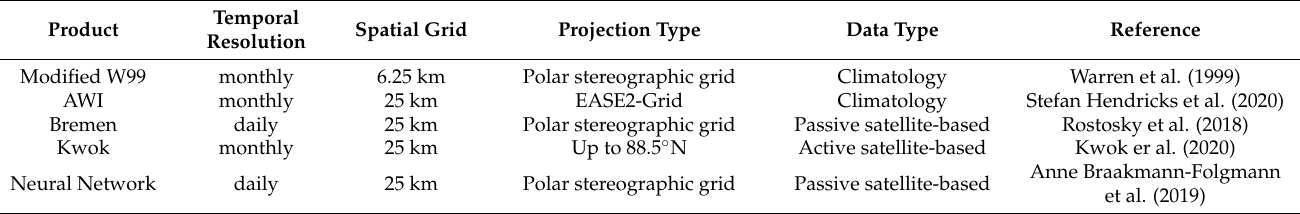
Table 1. Summary of current snow depth